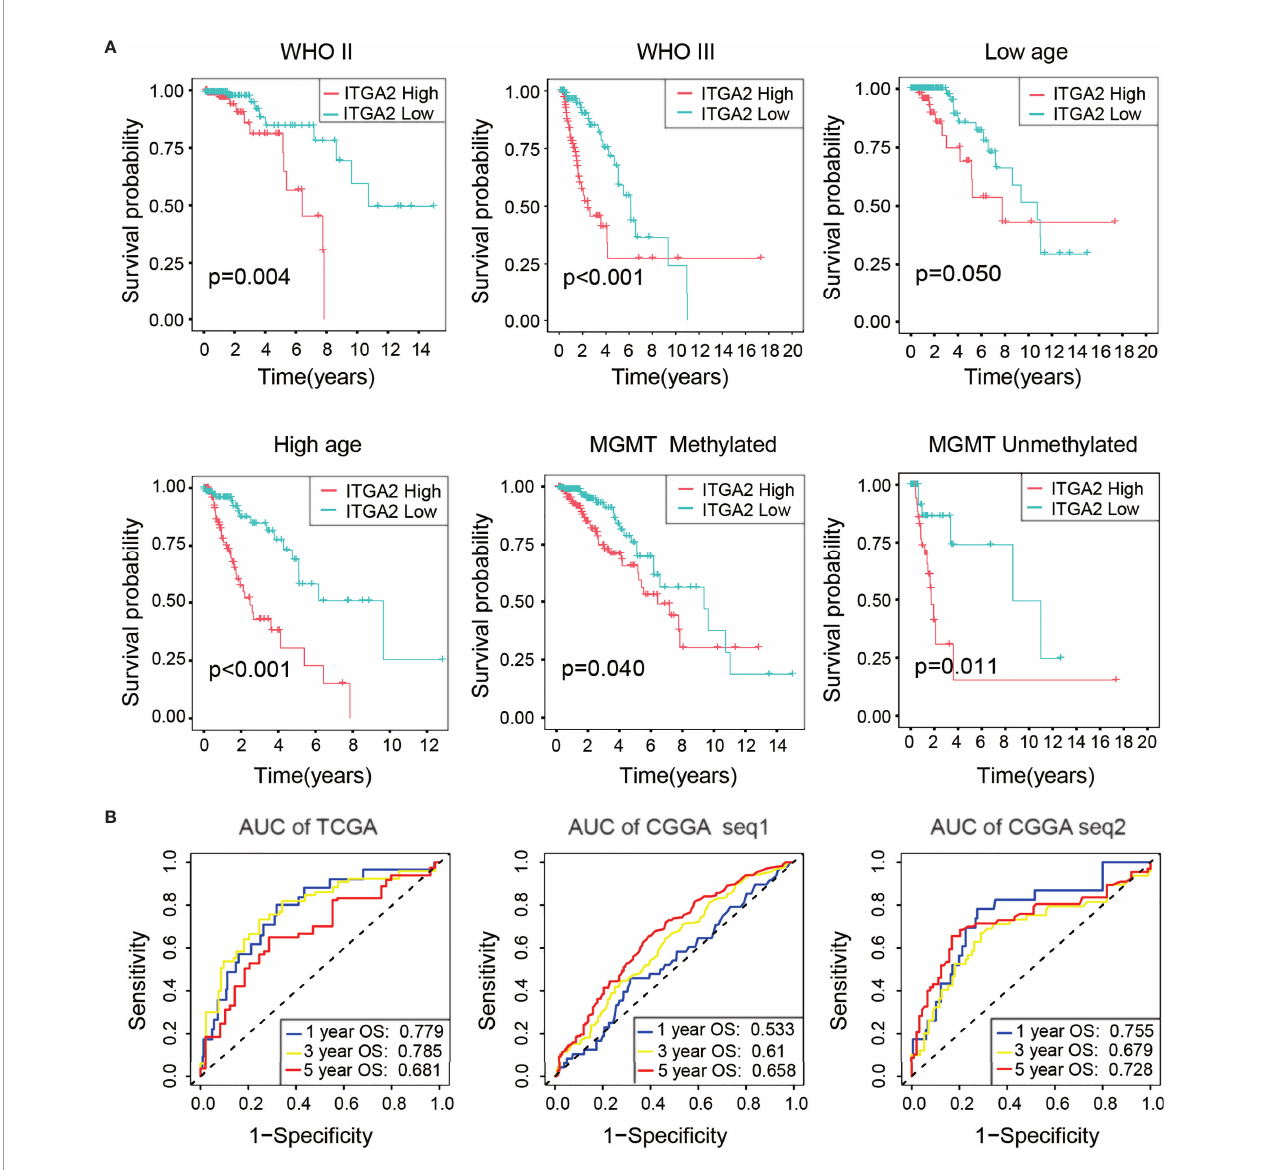
FIGURE 2 | Veri fi cation of the prognostic value of integrin alpha-2 in three cohorts. (A) Kaplan – Meier overall survival curves of patients with lower-grade glioma grouped by integrin alpha-2 expression in The Cancer Genome Atlas (TCGA) dataset and strati fi ed by World Health Organization grade, age, and O(6)- methylguanine-DNA methyltransferase status. (B) Time-dependent receiver operating characteristic curves for the prognostic model in a cohort from TCGA and two cohorts from the Chinese Glioma Genome Atlas, CGGAseq1 and CGGAseq2 (for predicting 1-, 3-, and 5-year overall